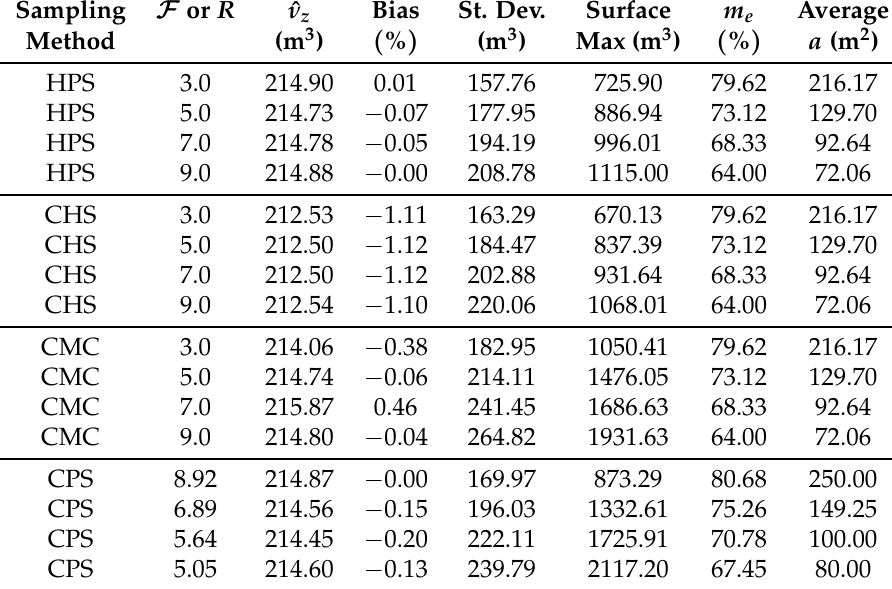
Table 1. Results of the sampling surface (sampSurf) simulations for the areal sampling